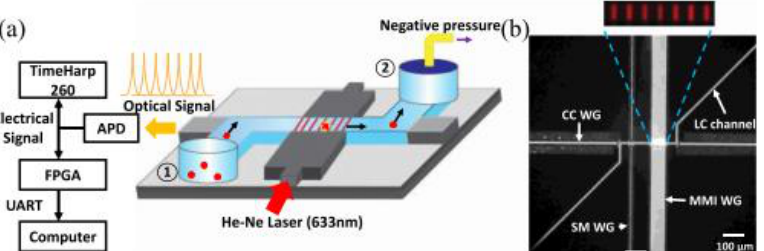
Figure 4. FPGA analysis platform based on ARROW optical flow control device. ( a ) Schematic diagram of devices used for fluorescence signal acquisition and analysis. ( b ) Optical microscope image of ARROW optical fluidic device. Reproduced with permission from Mohammad, J, N, S., IEEE PHOTONICS JOURNAL ; published by IEEE, 2021 [28].